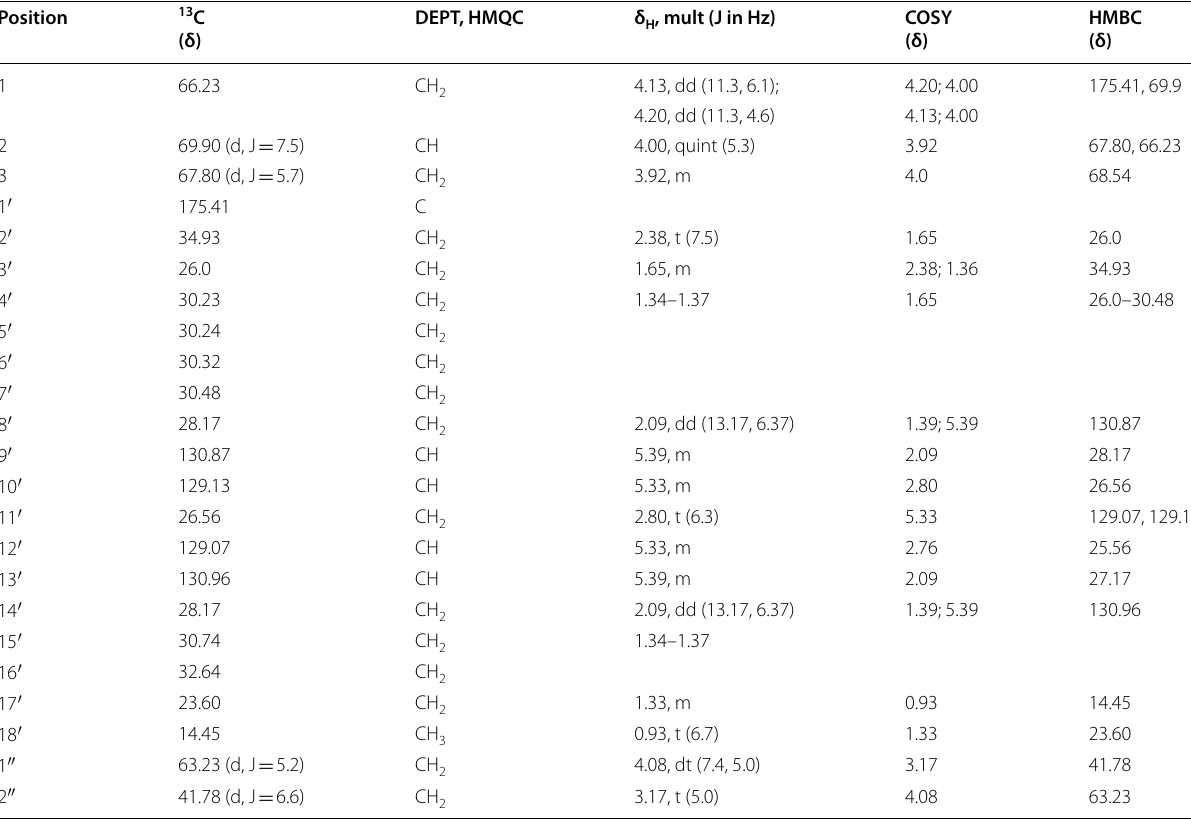
Table 4 1D and 2D NMR spectral data (δ in ppm) of compound 9